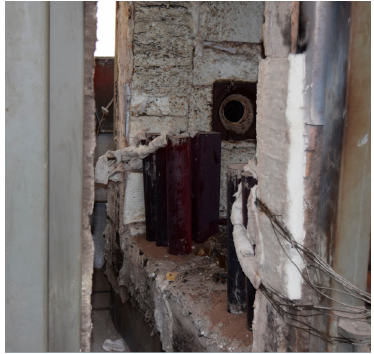
Figure 18. Natural cooling.